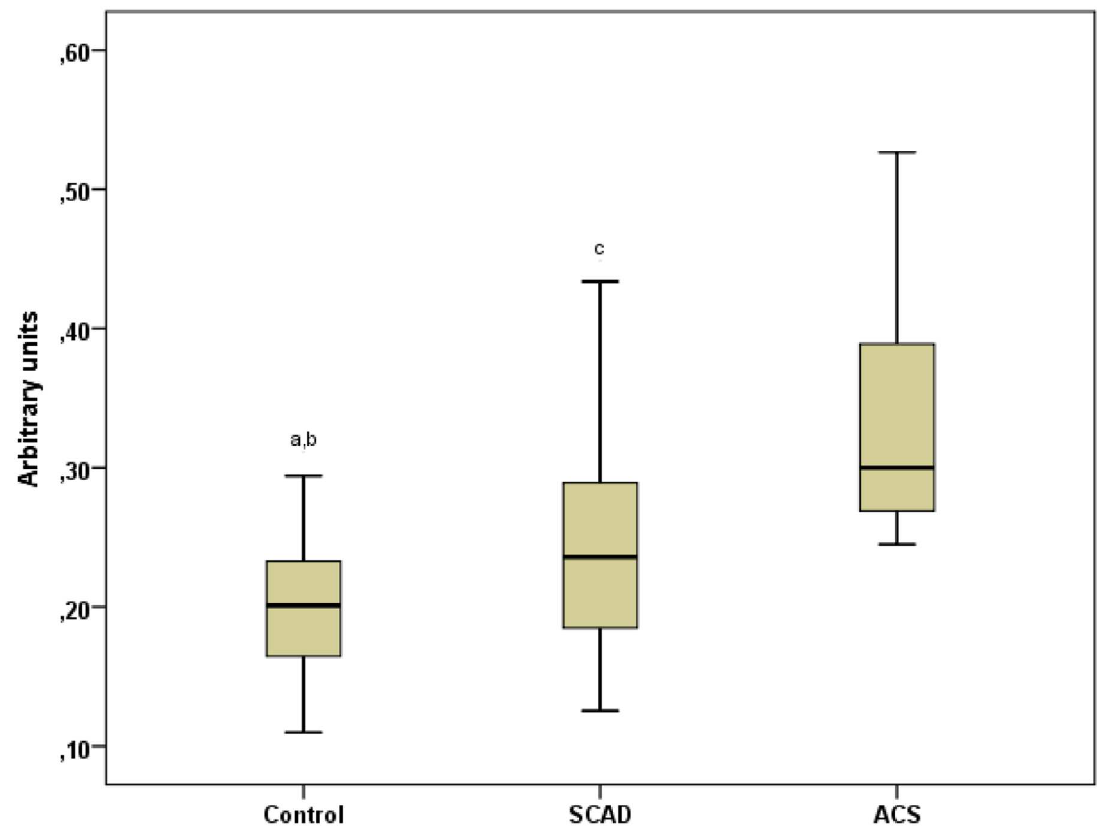
Fig 1. Expression of AnxA1 mRNA in isolated PBMCs from ACS patients, SCAD patients and controls. AnxA1 mRNA expressionwas analyzedin PBMCs collectedimmediately after density gradientisolationfrom 31 healthy controls, 49 SCAD patients and 10 ACS patients. The AnxA1 mRNA expressionis presented as arbitrary units and was calculatedusing the ΔΔ CT method. Each sample was run in duplicates. Box-and-whiskerplots show medianand interquartile range. Kruskal-Wallis test was used to assess differences betweenall groups, p < 0.001, and Mann-Whitney U-test was used for comparisons between2 groups; a p < 0.05 vs SCAD, b p < 0.001 vs ACS, c p < 0.01 vs ACS.